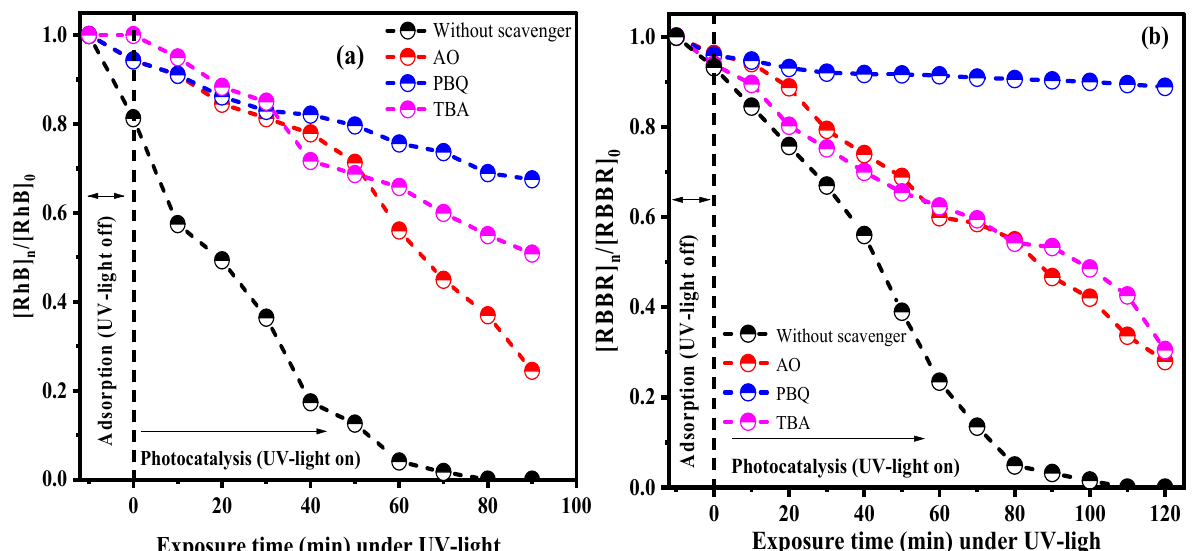
Figure 9. Catalytic performance of the PbMoO 4 nanocrystals in the photodegradation of ( a ) cationic (RhB) and an ( b ) anionic dye (RBBR) with the presence and absence of scavenger radicals (OA, PBQ and TBA).